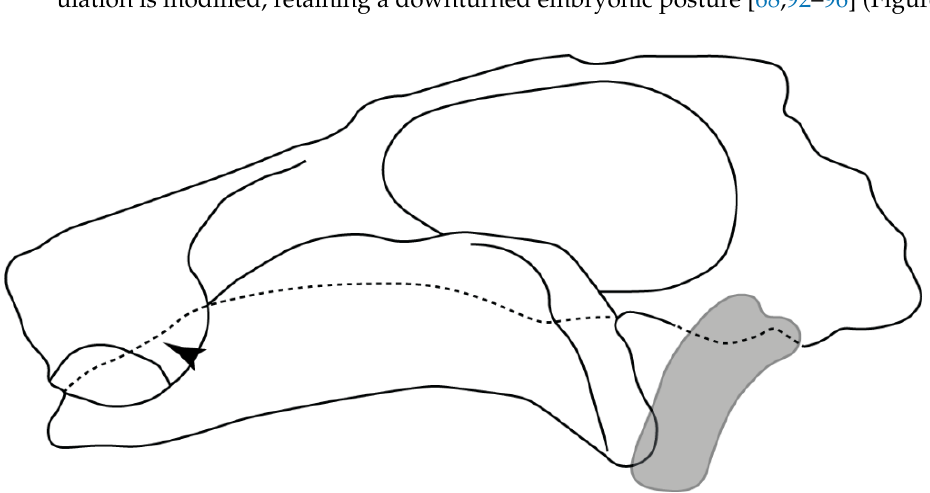
Figure 23. State (1): Interpretative drawing of neurocranium and palatoquadrate of Heterodontus francisci redrawn and modified from Maisey Text-Figure 6D in [92]. Arrowhead: ethmoidal articulation. Hyomandibula in gray color.